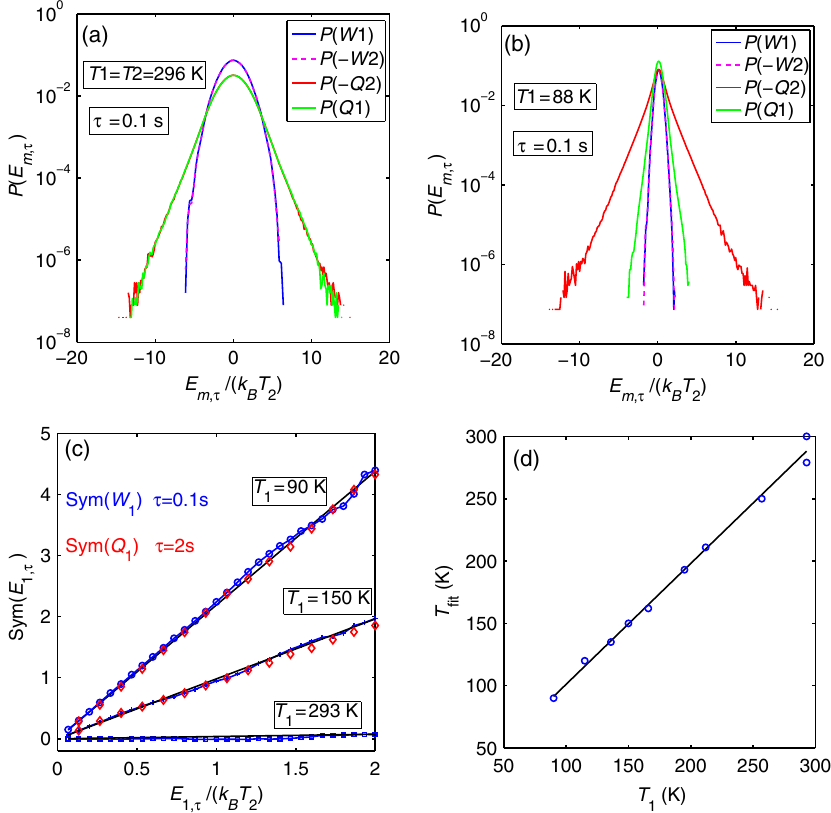
Þ and P ð Q Þ , measured in equilibrium at T ¼ T ¼ 296 K and τ ¼ 0 . 1 s , are plotted as functions of 1 2 m; τ m; τ Þ ¼ P ð − W Þ and P ð Q Þ ¼ P ð − Q Þ . 2 ; τ 1 ; τ 2 ; τ ; τ Þ ¼ P ð − W Þ but P ð Q Þ ≠ P ð − Q Þ . The reason for this difference is explained in the 2 ; τ 1 ; τ 2 ; τ ; τ Þ , measured at various T 1 , is plotted as a function of E 1 ( W 1 or Q 1 ). The theoretical slope of ; τ estimated from the slopes of the lines in (c) is plotted as a function of the T 1 fit ≃ T 1 within a few fit